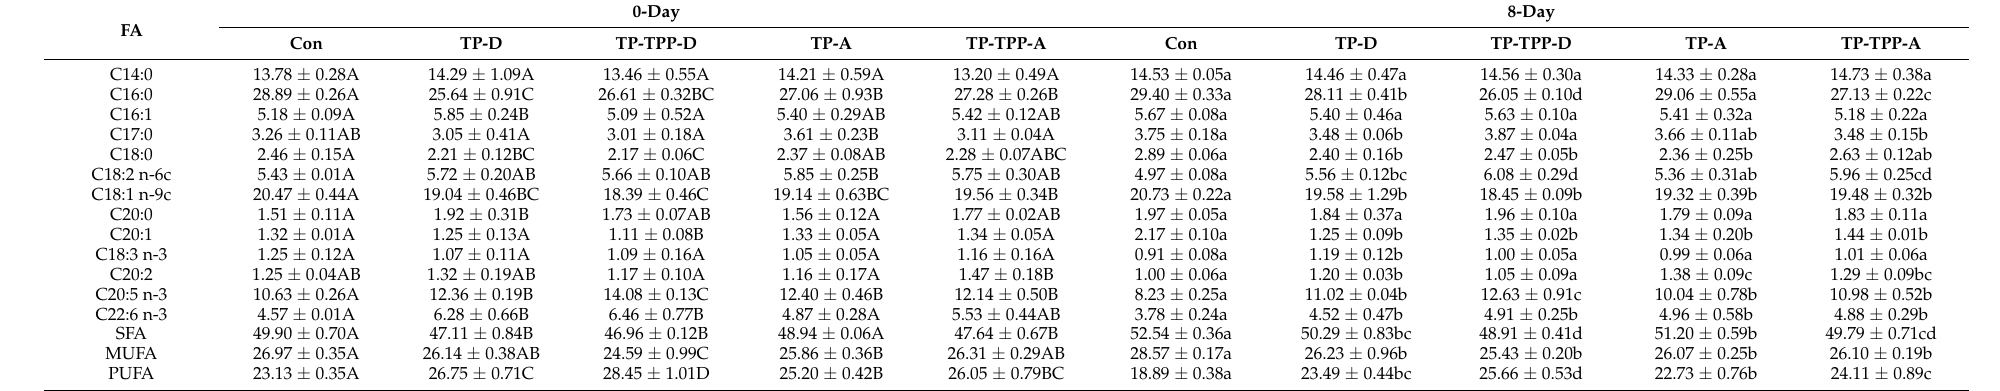
Table 3. The FA composition (relative content, %) of krill oils added with different antioxidants in the accelerated storage at 60 ◦ C.